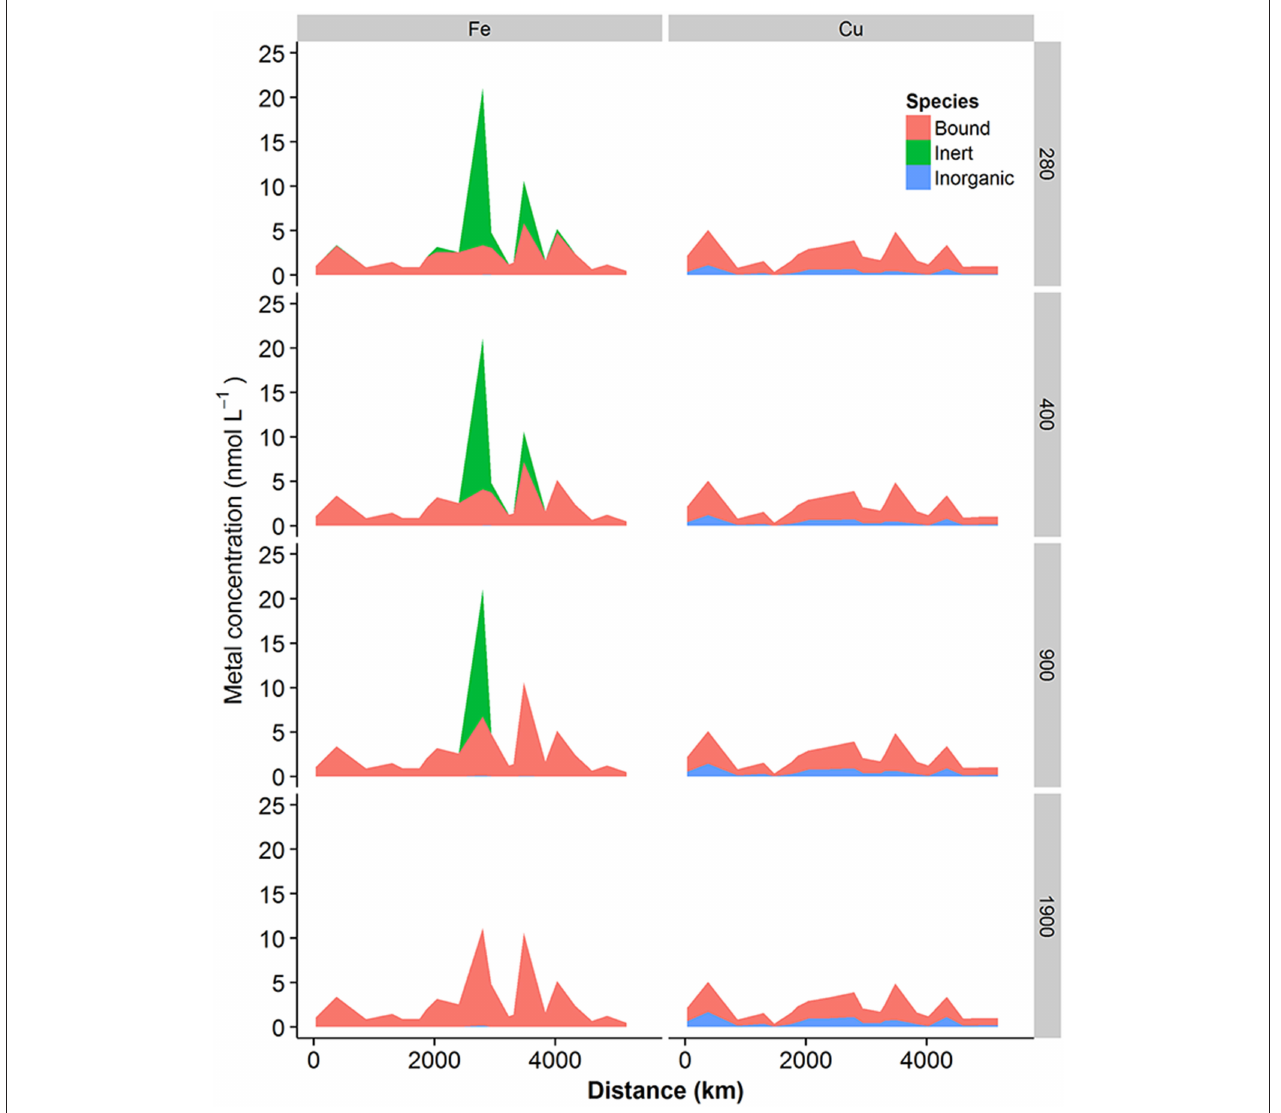
FIGURE 8 | Concentrations of metal complexed with DOM (bound), inert (ferrihydrite, iron only) or labile inorganic complexes (OH − , CO 2 − 3 , etc) calculated for increasing concentrations of atmospheric CO 2 . Iron speciation is presented in the left column and copper speciation in the right column. p CO 2 Applied to the model is indicated to the right of the